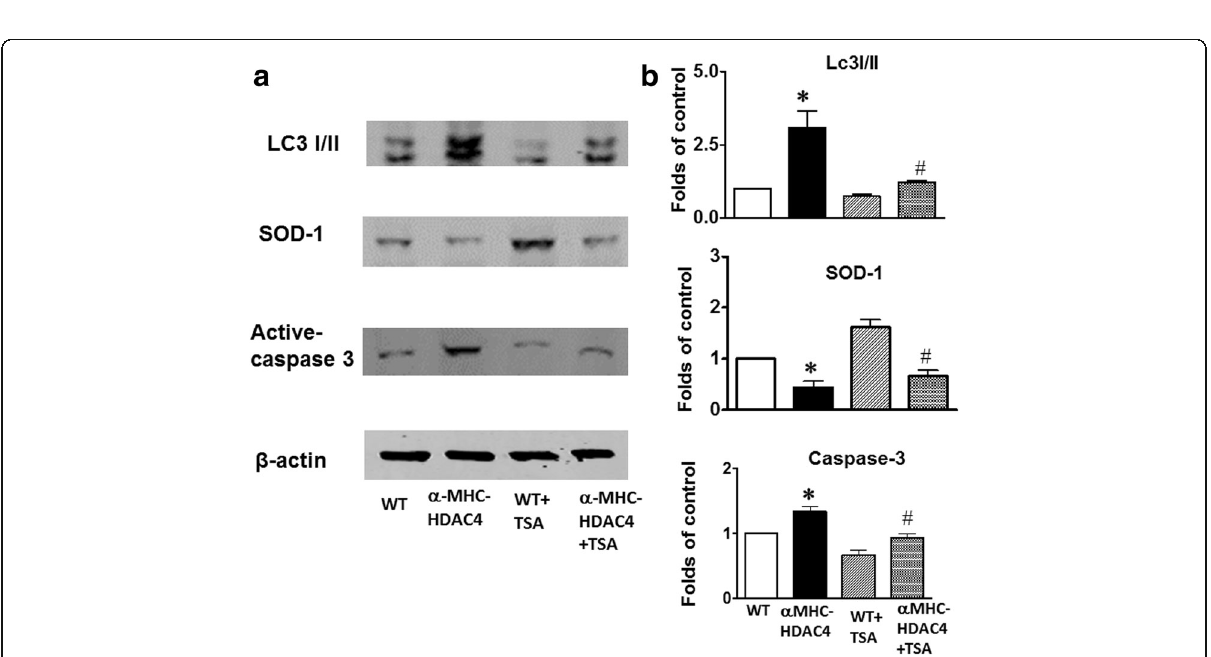
Fig. 6 Active HDAC4 increased active caspase 3 and autophagy and decreased SOD1. a Western blot showing increased active caspase-3, decreased SOD-1, and increased LC-3I/II in the heart from HDAC4 transgenic mice; b Densitometric analysis of each protein level relative to wild type ( n =3 per group); Values represent mean±SE, * p <0.05 vs WT; # p <0.05 vs WT+TSA. SOD: Superoxide dismutase; LC3: autophagosome associated lipidated isoform